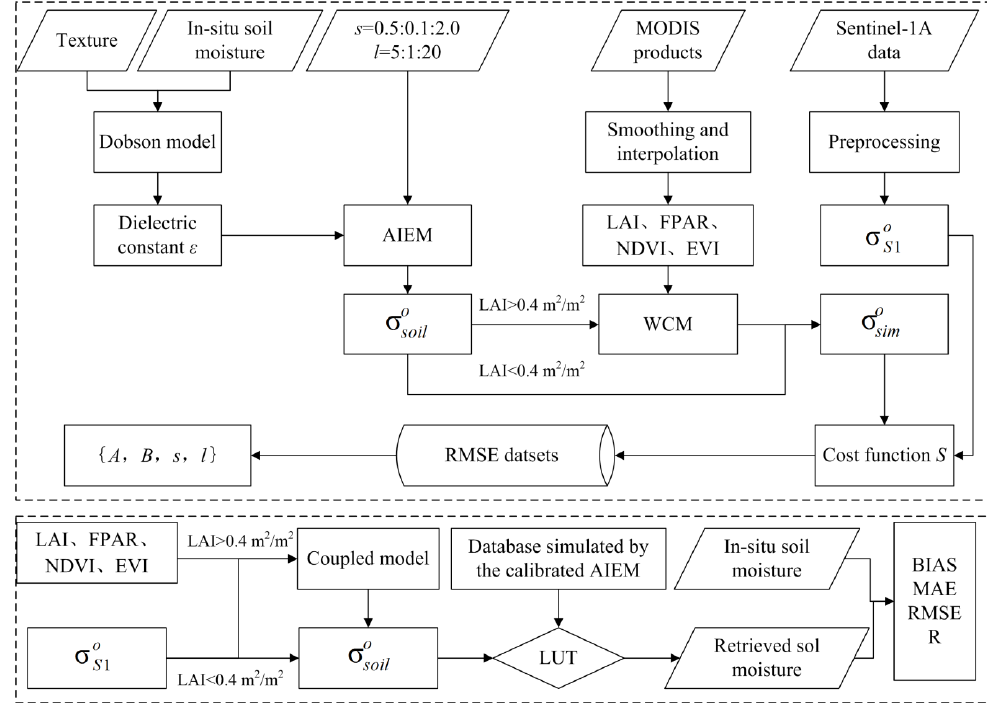
Figure 4. Flowchart for the model calibration and the soil moisture retrieval. The AIEM and WCM stand for the advanced integral equation model and the water cloud model, respectively. The LUT is the look-up-table. The BIAS (the mean bias), MAE (mean absolute error), RMSE (root mean square error), R (Pearson correlation coefficient) are statistical indicators.